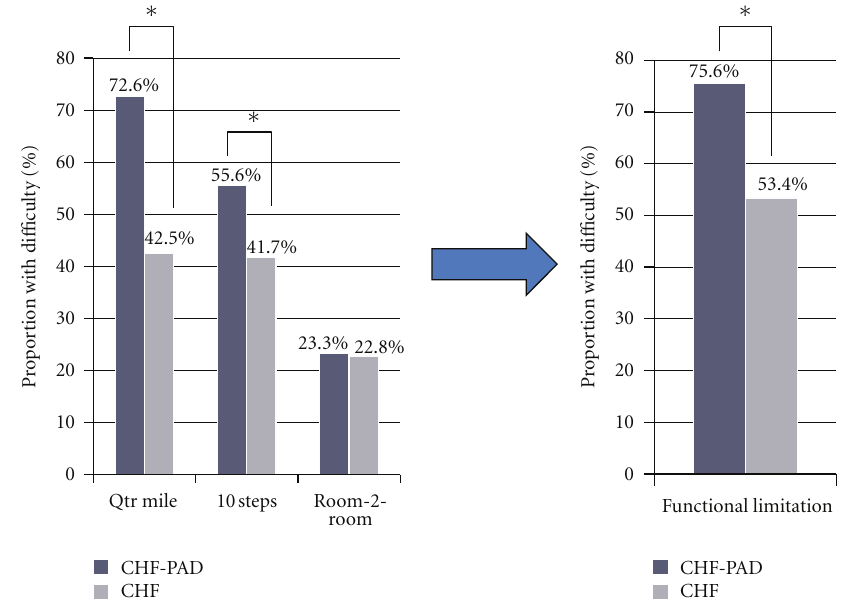
Figure 1: Distribution of functional limitation in CHF-PAD and CHF